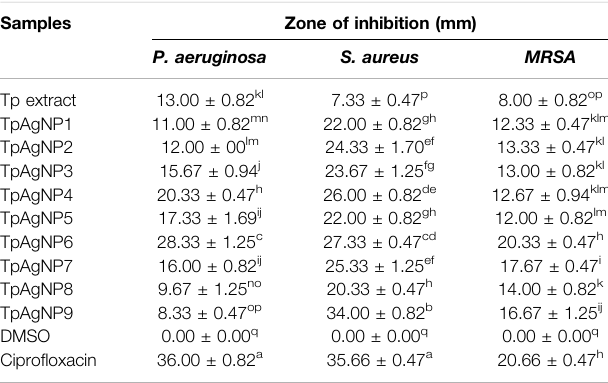
TABLE 3 | Zone of inhibition of plant extract and TpAgNPs of T. pallida against different bacterial strains.